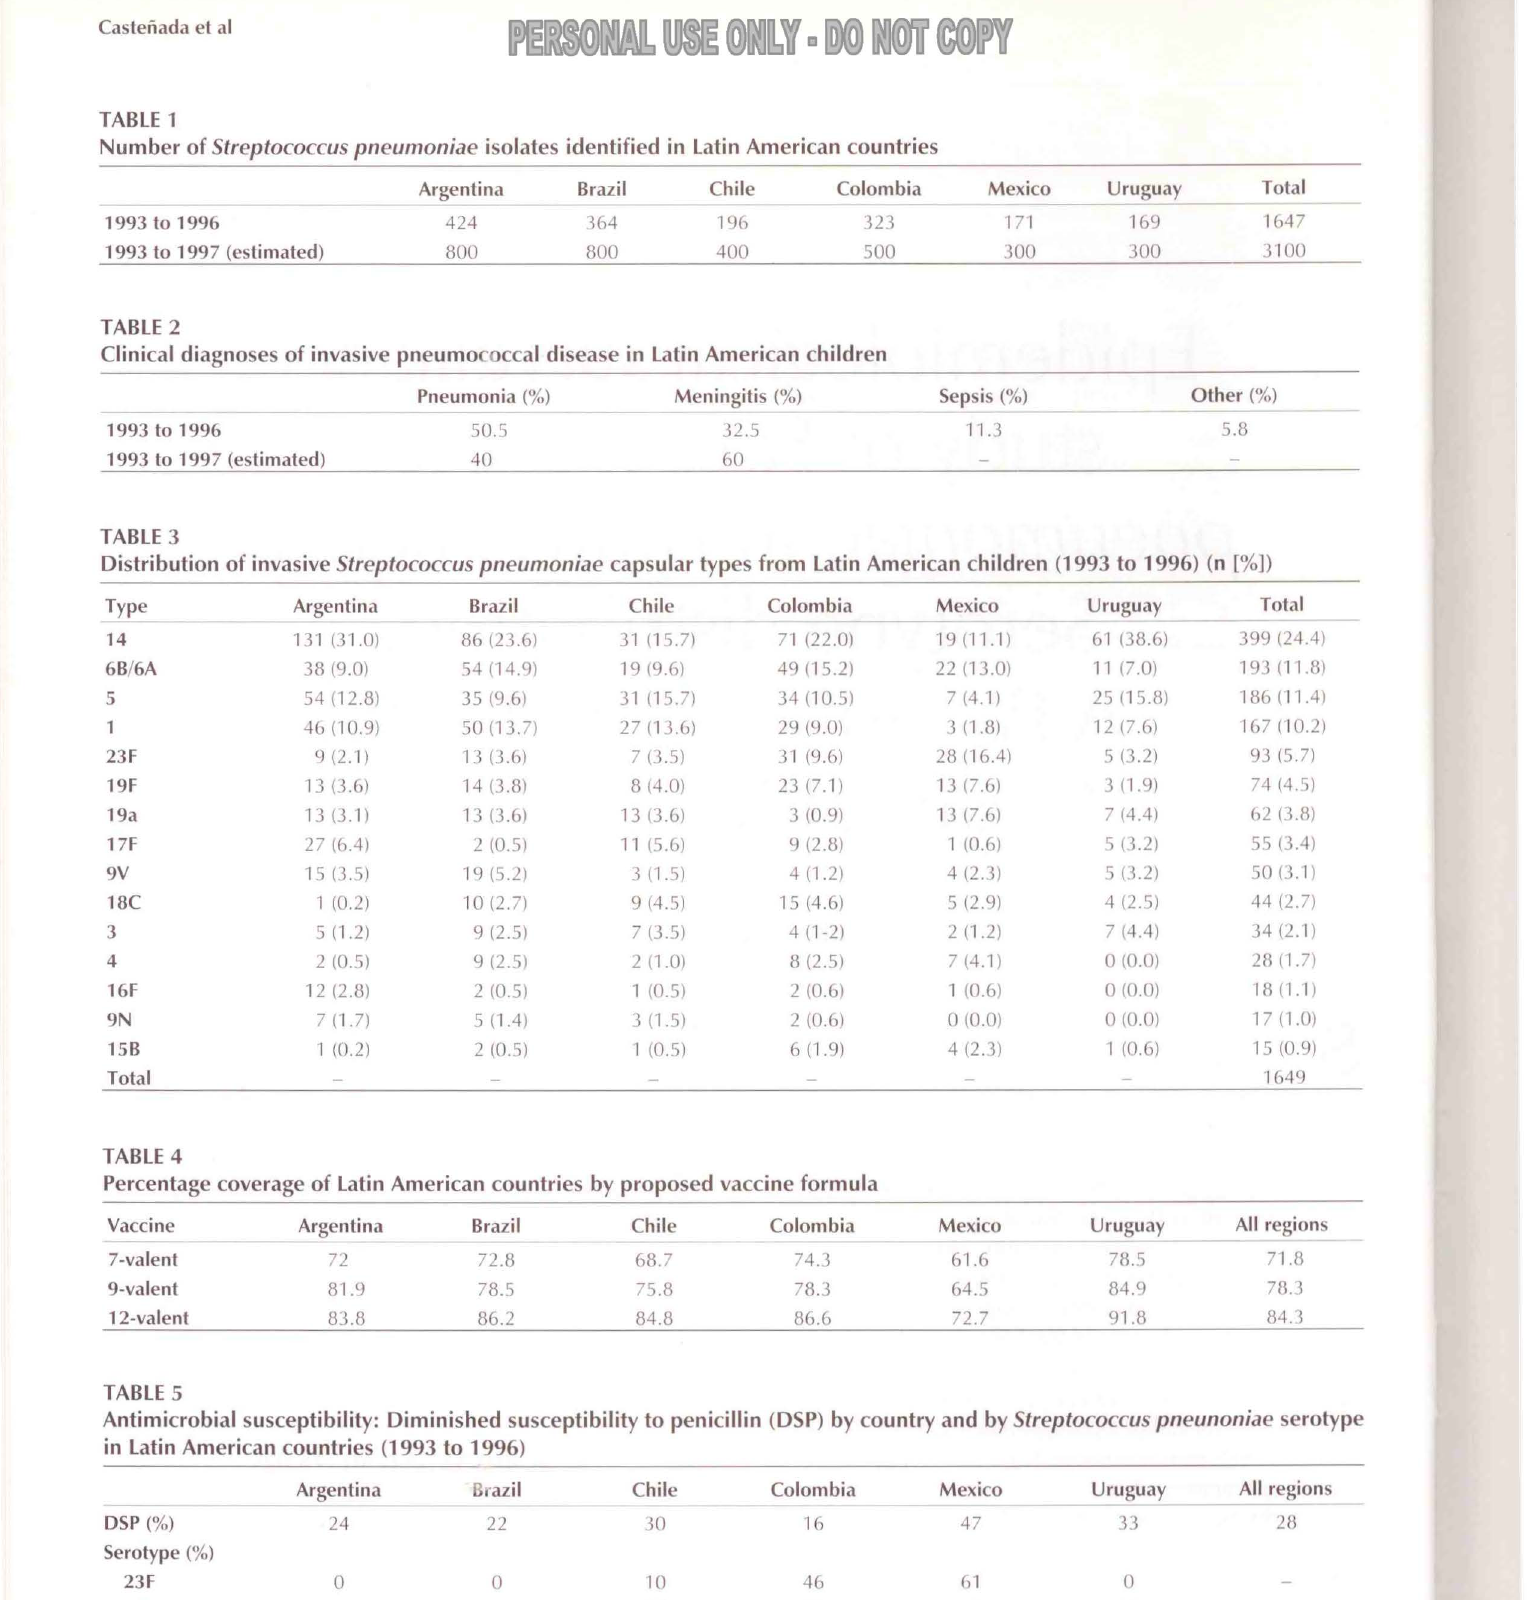
Antimicrobial susceptibility: Diminished susceptibility to penicillin (DSP) by country and by Streptococcus pneunoniae